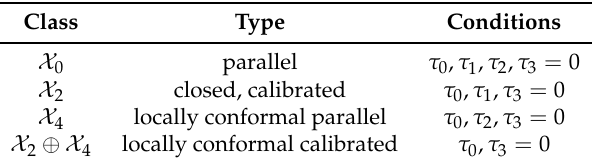
Table 1. Some classes of G 2